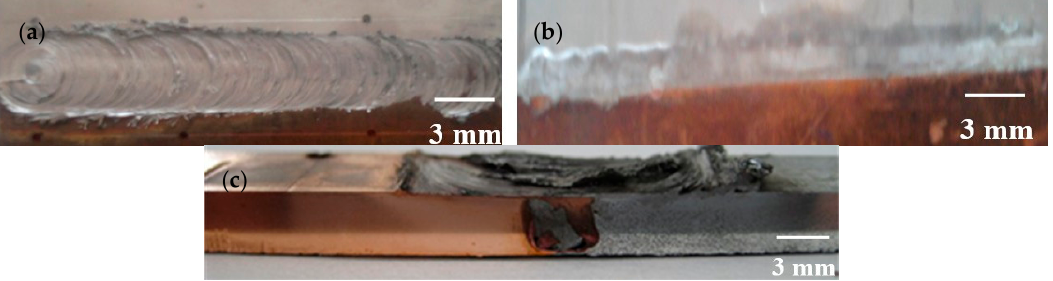
Figure 4. Welded part macro ‐ images under 1330/20/1 condition ( a ) Upper surface; ( b ) Lower surface; ( c ) Cross section.